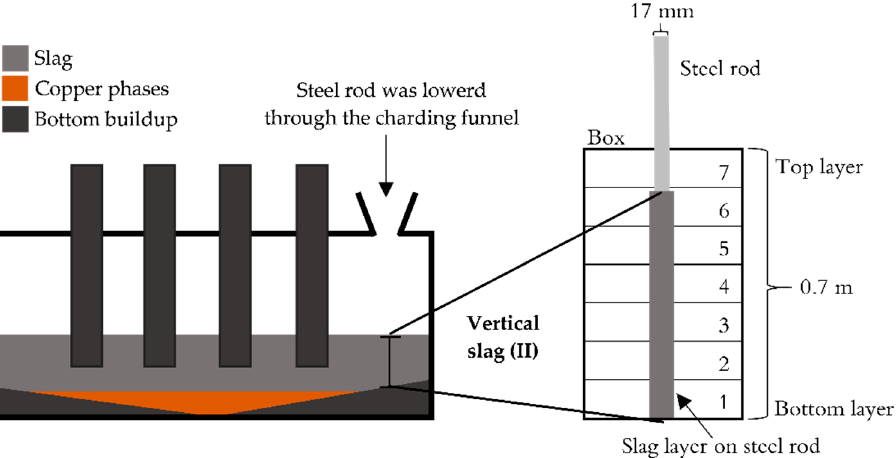
Figure 2. Schematic of the electric settling furnace and the steel rod and box used to collect and divide vertical slag samples into different levels.